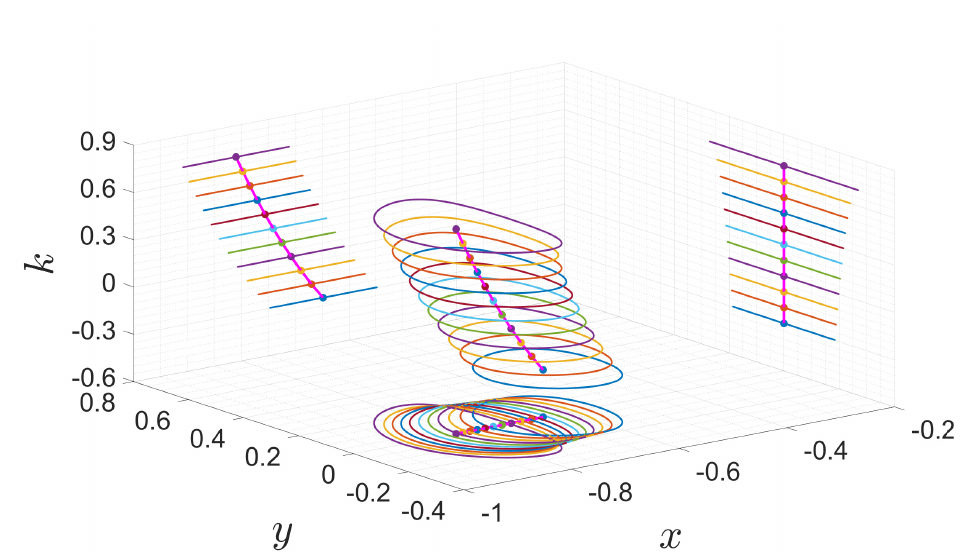
Figure 5. Third-order periodic orbits and their planar projections under different k -values.